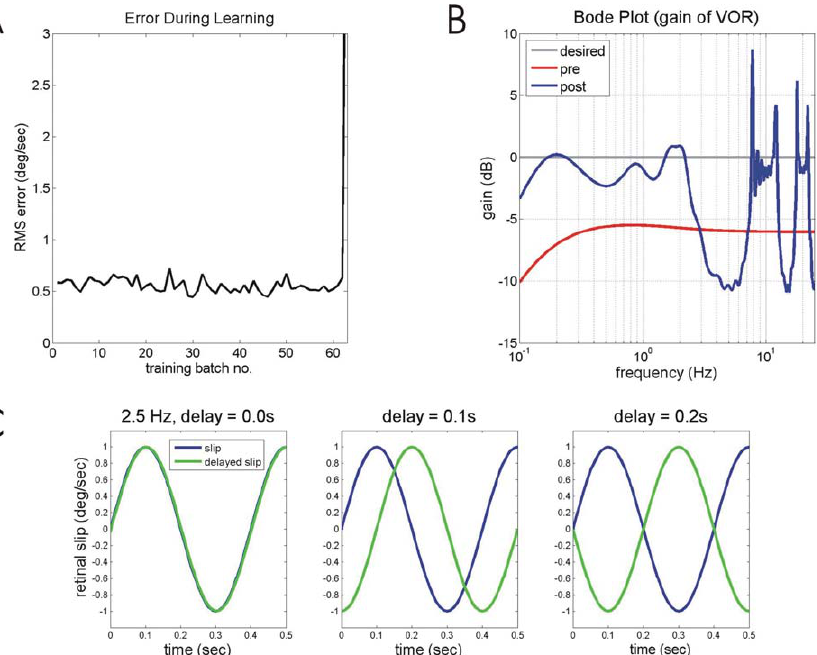
Figure 4. Model Performance Before, During, and After Training with a Retinal-Slip Signal Delayed by 0.1 s (A) Change in retinal-slip amplitude with training. It initially declines much more slowly than with an undelayed signal (Figure 3), and eventually increases very rapidly as the system becomes unstable. (B) System gain for sinusoidal input signals as a function of frequency, measured just before the instability shown in (A). The gains at frequencies above 2.5 Hz are inaccurate. (C) Effects of delay on correlation between two identical sinusoids at 2.5 Hz. As delay increases from a value of 0 s, the correlation declines from 1.0 to 0 at a delay of 0.1 s, and to (cid:2) 1.0 at a delay of 0.2